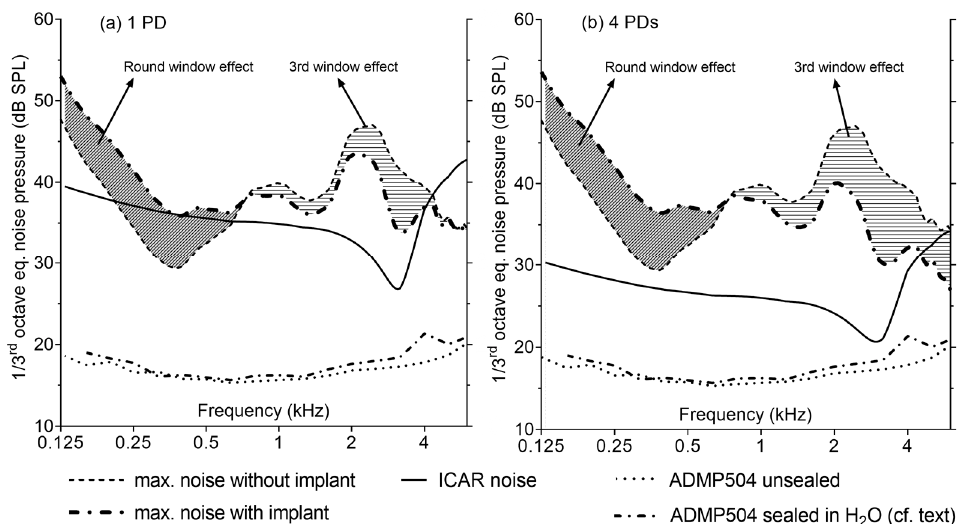
Figure 13. ( a ) Predicted (LEM) one-third octave equivalent noise pressure of the proposed intracochlear acoustic receiver (ICAR) with one and ( b ) four protective diaphragms (PDs) and equipped with the ADMP504 MEMS microphone. The sensor performance is compared with the noise requirements for an implant inserted in the scala tympani (ST). The dashed areas reflect potential deviations in intracochlear sound pressure caused by round window (RW) reinforcement (doubled RW stiffness) and sensor input impedance (third window effect). The experimentally determined noise characteristics of the ADMP504 microphone in an unsealed and sealed configuration (operating in water) are also shown. For the purpose of comparison, the frequency response of the unsealed microphone is used for the noise calculation of both sensor configurations.